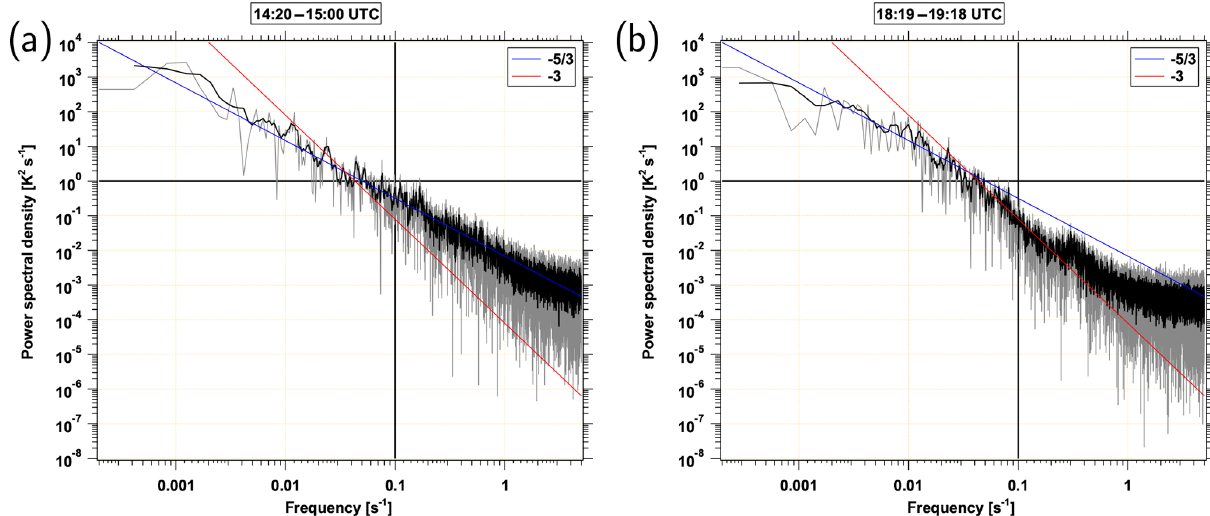
Figure 6. Power spectral densities of measured potential temperature from HALO for selected time periods: (a) 14:20–15:00UTC and (b) 18:19–19:18UTC. Black solid lines are introduced for better comparability, red solid line shows a line with a slope of k = − 3, blue solid line shows a line with a slope of k = − 5 /